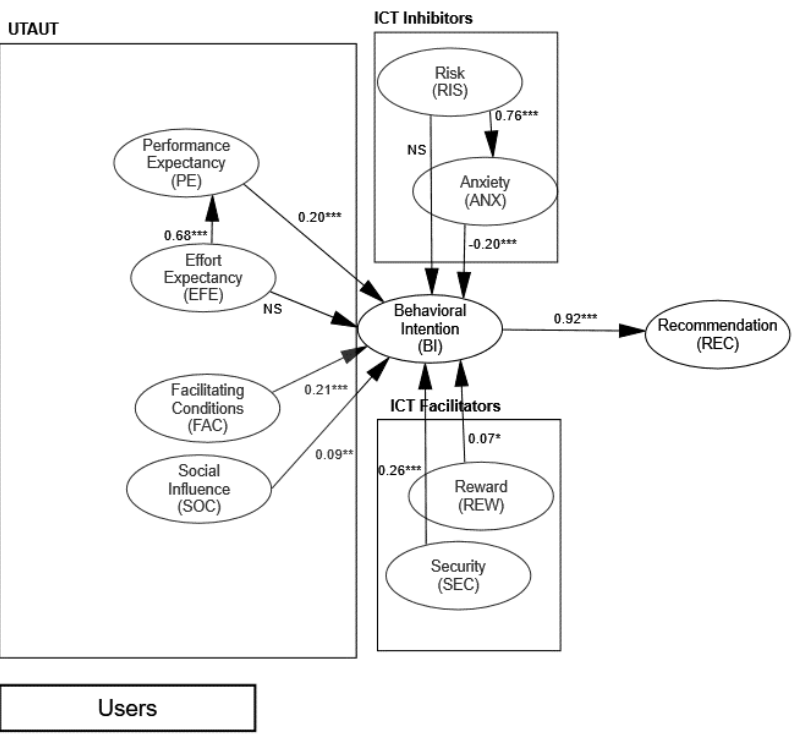
Figure 2. Validated conceptual model—Users. p < 0.1, * p < 0.05, ** p < 0.01, *** p < 0.001, NS: Non-Significant.